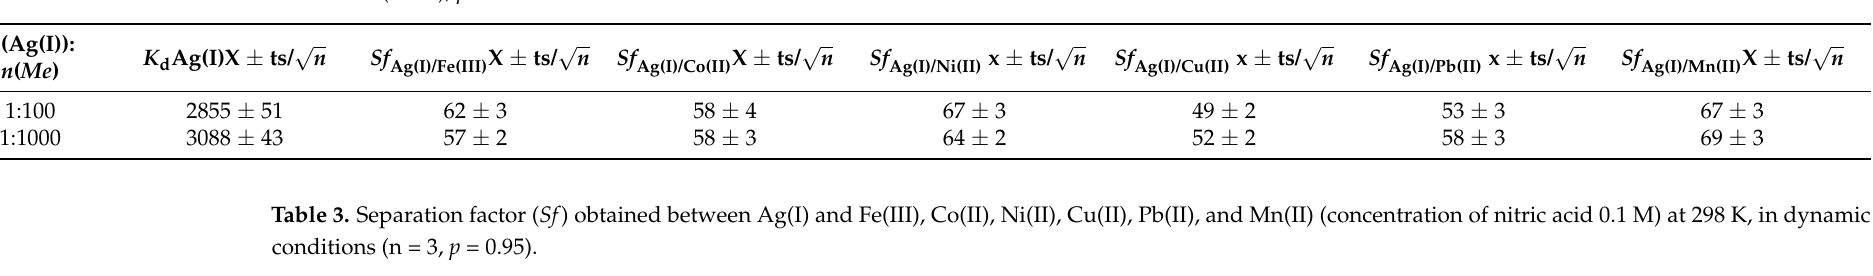
Table 2. Separation factor ( Sf ) obtained between Ag(I) and Fe(III), Co(II), Ni(II), Cu(II), Pb(II), and Mn(II) (concentration of nitric acid 0.1 M) at 298 K, in static conditions (n = 4), p = 0.95.